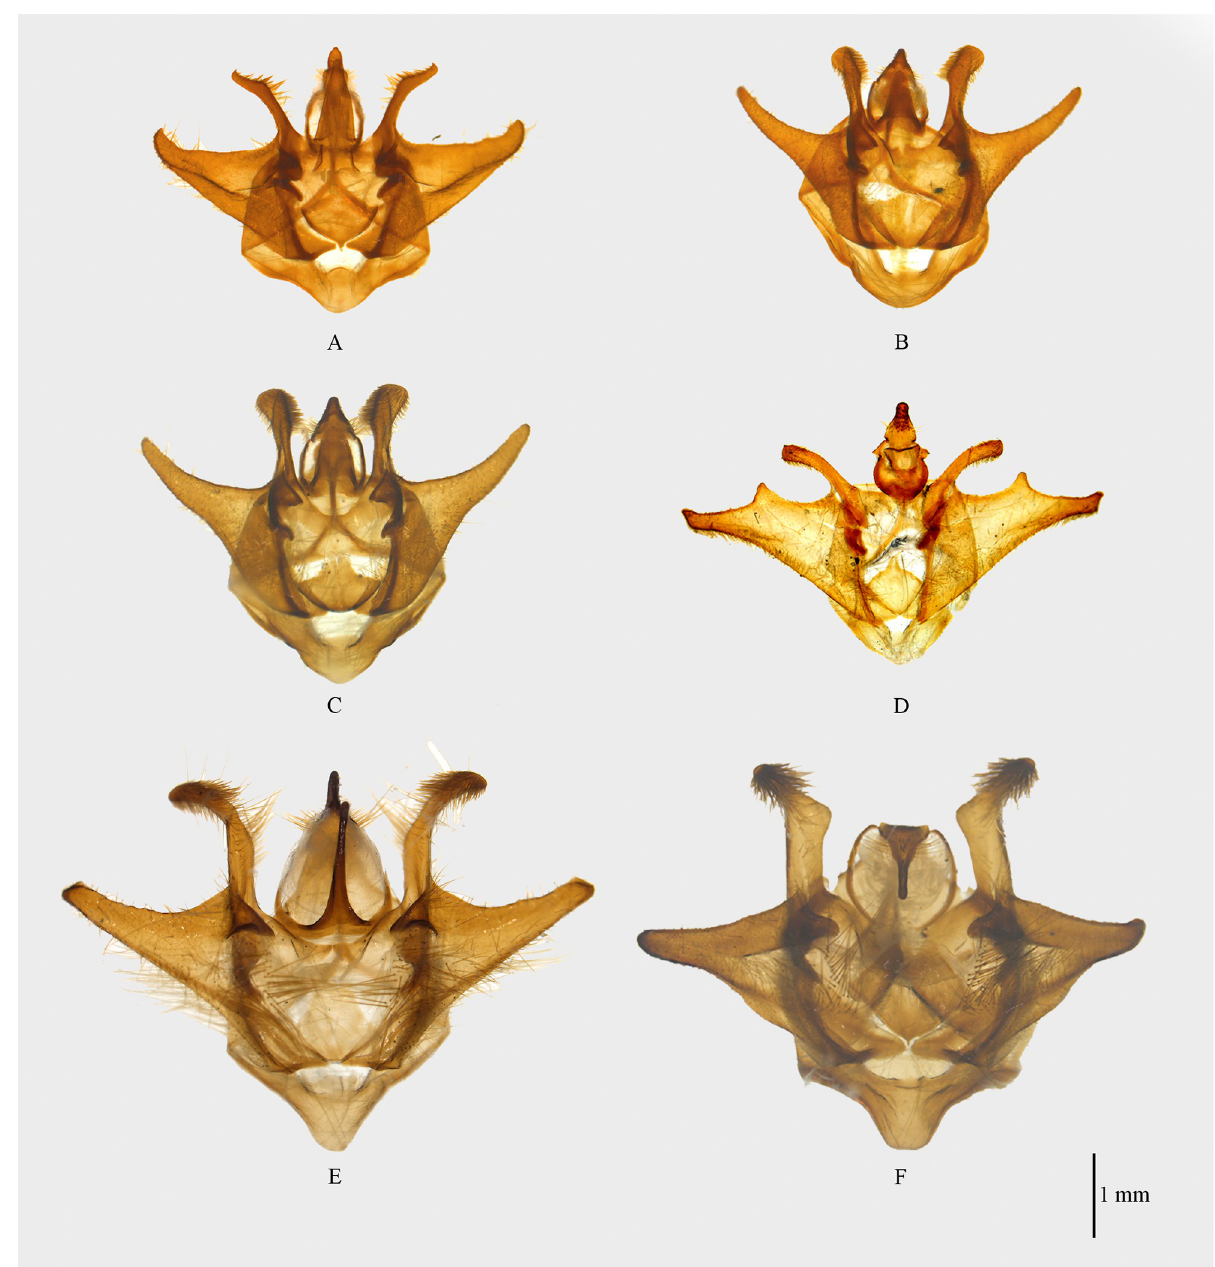
Fig 9. Male genitalia of Psyra . A. P . similaria (Dihang Dibang Biosphere Reserve morph) B. P . debilis debilis C. P . debilis indica D. P . falcipennis E. P . crypta F. P . spurcataria .